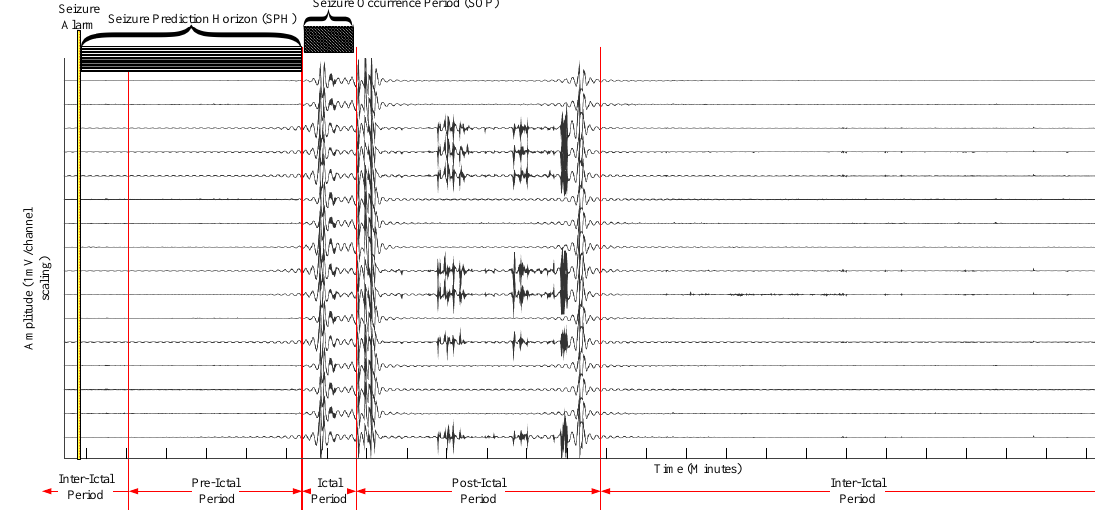
Figure 2. Four states of ElectroCorticoGraph (ECoG) of an epileptic patient [22]. A snapshot of data captured from an array of 16 brain implanted electrodes of an epileptic patient with generalized tonic-clonic seizure. The sampling rate is 500 Hz and is recorded for a total duration of 40 h. Duration of the seizure prediction horizon and the seizure occurrence period are illustrated with respect to the onset of a seizure alarm. (A snapshot of ECoG signal obtained from intracranial ElectroEncephaloGraphy (iEEG) viewer